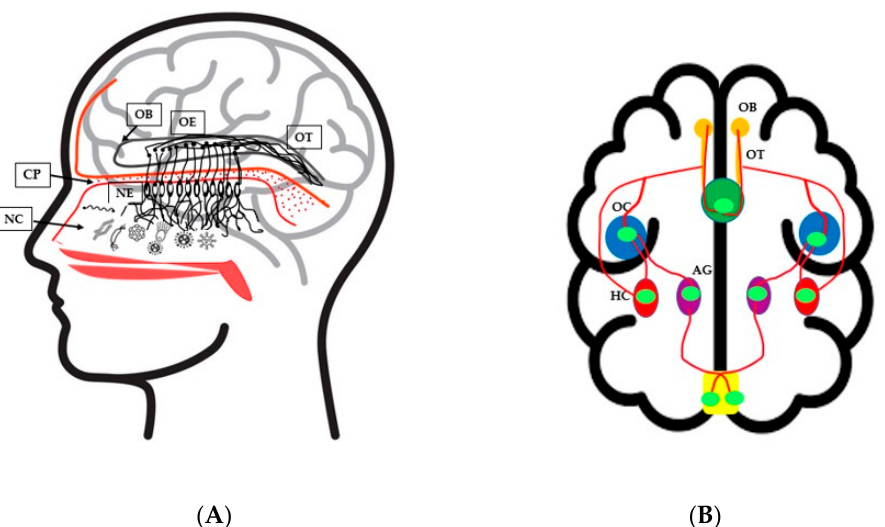
Figure 1. ( A ) Nasal microbiota interactions with the olfactory system that influence olfactory func- tions. Microorganisms enter through respiratory airways and interact with olfactory receptor cells (Orc) of the neuroepithelium (NE) that protrude through the perforations in the cribriform plate (CP) and extend its connections with olfactory neurons (ON) in the olfactory bulb (OB). The tuft of ONs forms the olfactory tract (OT), which connects to other olfactory cortices (OC); ( B ) Interactions of olfactory neurons within the brain. The tuft of olfactory nerve fibers from OT receives connections from the neurotransmitter system and OC. ON interacts with OC, hippocampus (HC), amygdala (AG), entorhinal cortex (EC), hypothalamus (HT), and locus coeruleus and reaches the reticular formation system (RFS), where the visceral responses of smell can be produced.